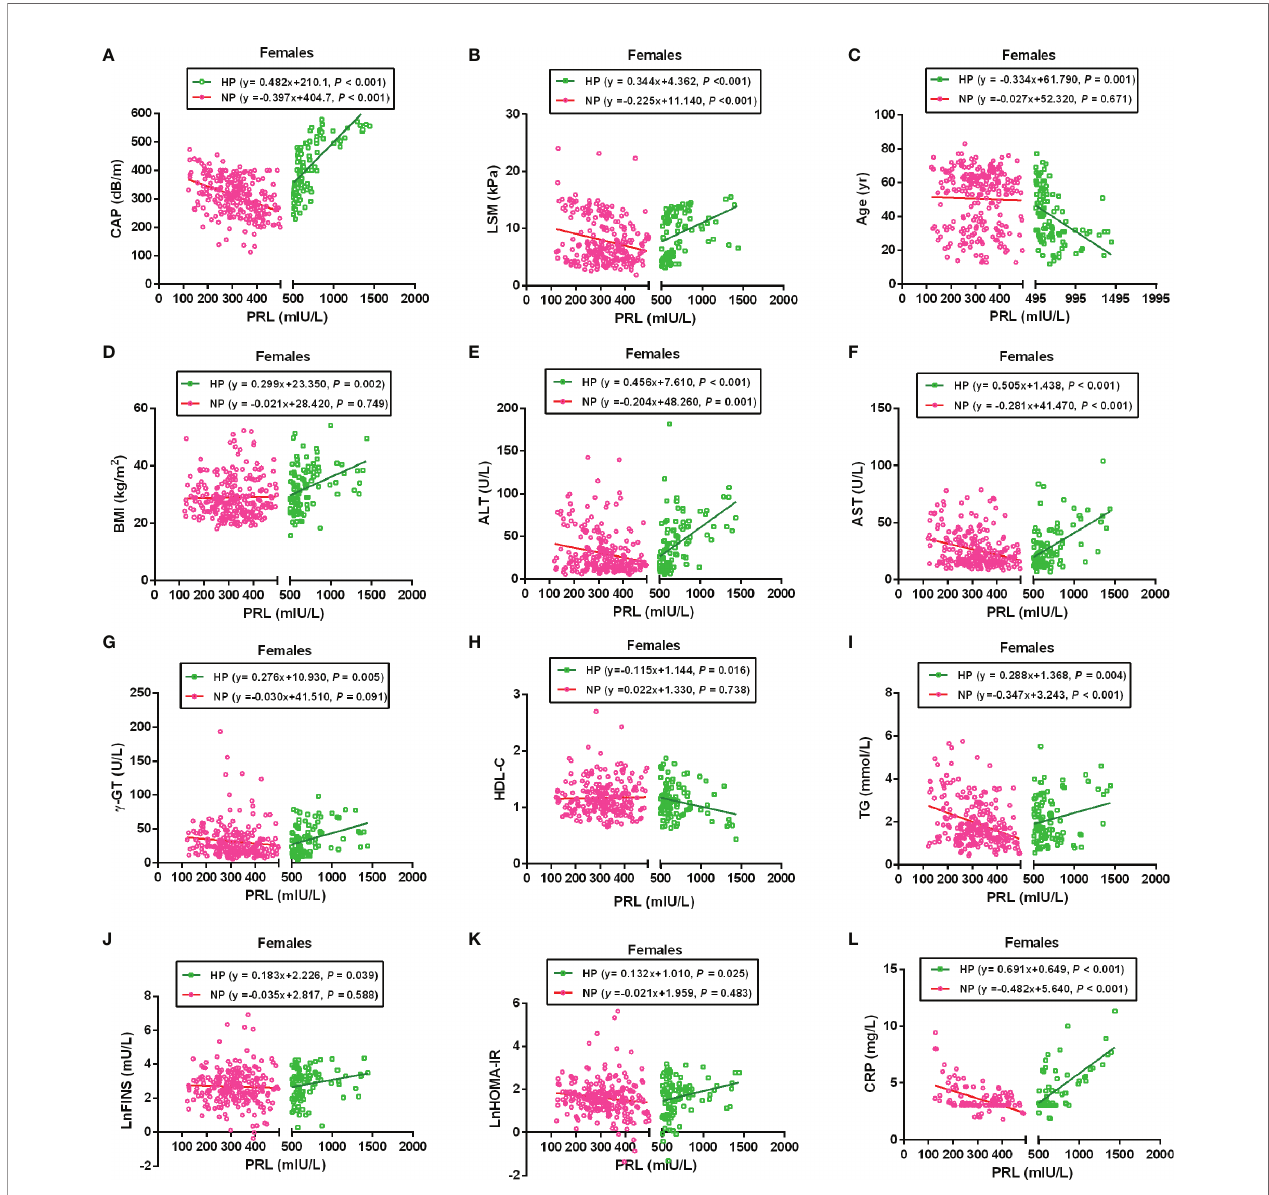
FIGURE 4 | Linear regression analysis shows the relationship between PRL and MAFLD-related risk factors among females. These factors included CAP (A) , LSM (B) , Age (C) , BMI (D) , ALT (E) , AST (F) , g -GT (G) , HDL-C (H) , TG (I) , LnFINS (J) , LnHOMA-IR (K) , and CRP (L) . In the NP group, serum PRL was signi fi cantly negatively associated with CAP, LSM, ALT, AST, TG, and CRP but not with age, BMI, g -GT, HDL-C, LnFINS, and LnHOMA-IR. In the HP group, serum PRL was signi fi cantly positively associated with CAP, LSM, BMI, ALT, AST, g -GT, TG, LnFINS, LnHOMA-IR, and CRP but negatively associated with age and HDL-C. PRL, prolactin; CAP, controlled attenuation parameter; LSM, liver stiffness measurement; ALT, alanine transaminase; AST, aspartate aminotransferase; g -GT, gamma- glutamyl transferase; HDL-C, high-density lipoprotein cholesterol; TG, triglyceride; FINS, fasting insulin; HOMA-IR, homeostasis model assessment of insulin resistance; CRP, C-reactive protein. Non-normally distributed data were log-transformed before analysis. P -values < 0.05 were accepted as statistically signi fi